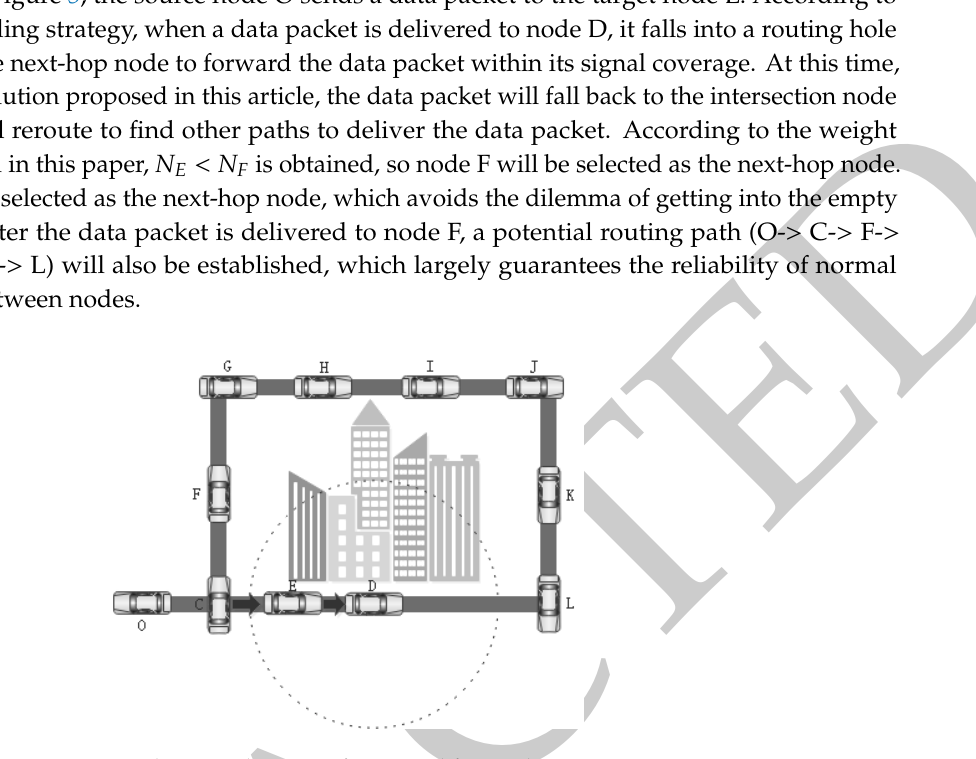
Figure 5. Schematic diagram of restricted forwarding strategy.